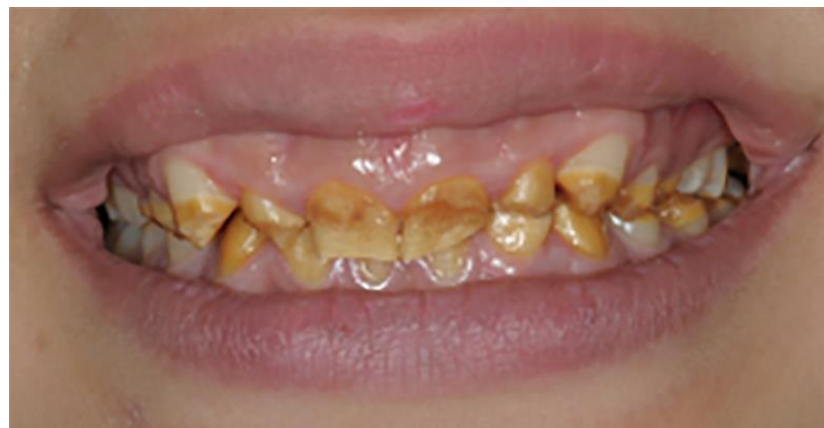
Figure 10. Case 3—Extraoral view of the patient with amelogenesis imperfecta.